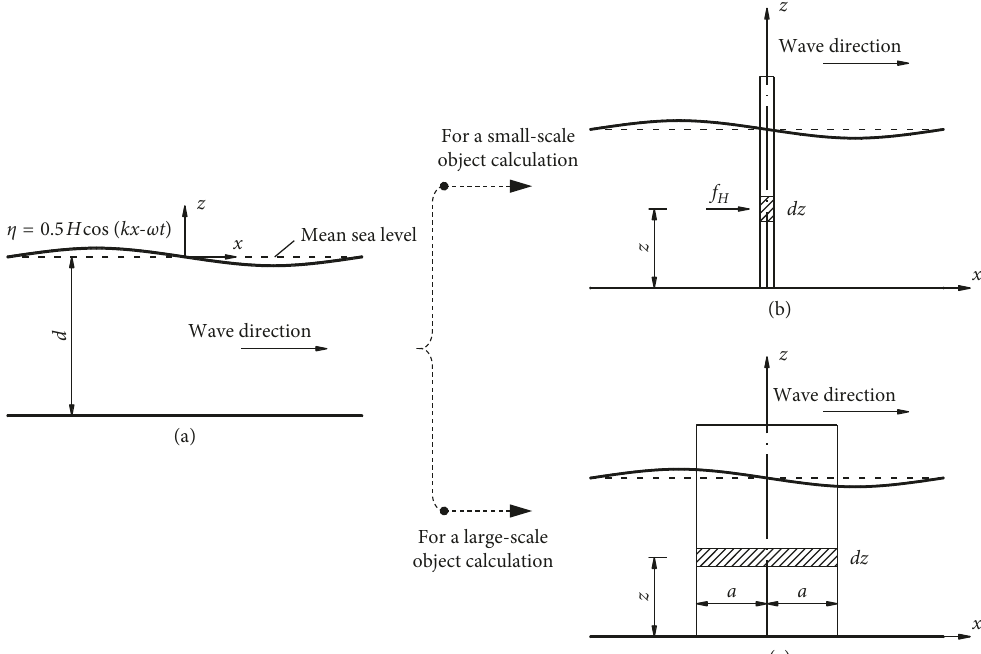
Figure 3: Computations of wave forces. (a) Schematic diagram of the linear wave theory. (b) For a small-scale object. (c) For a large-scale object.